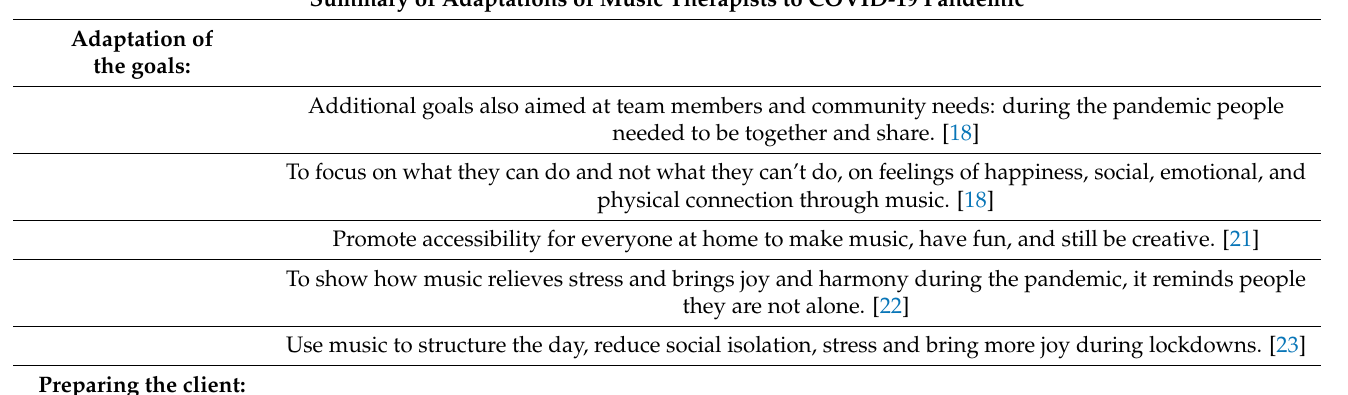
Table 2. Summary of adaptations of music therapists to the COVID-19 pandemic. Summary of Adaptations of Music Therapists to COVID-19